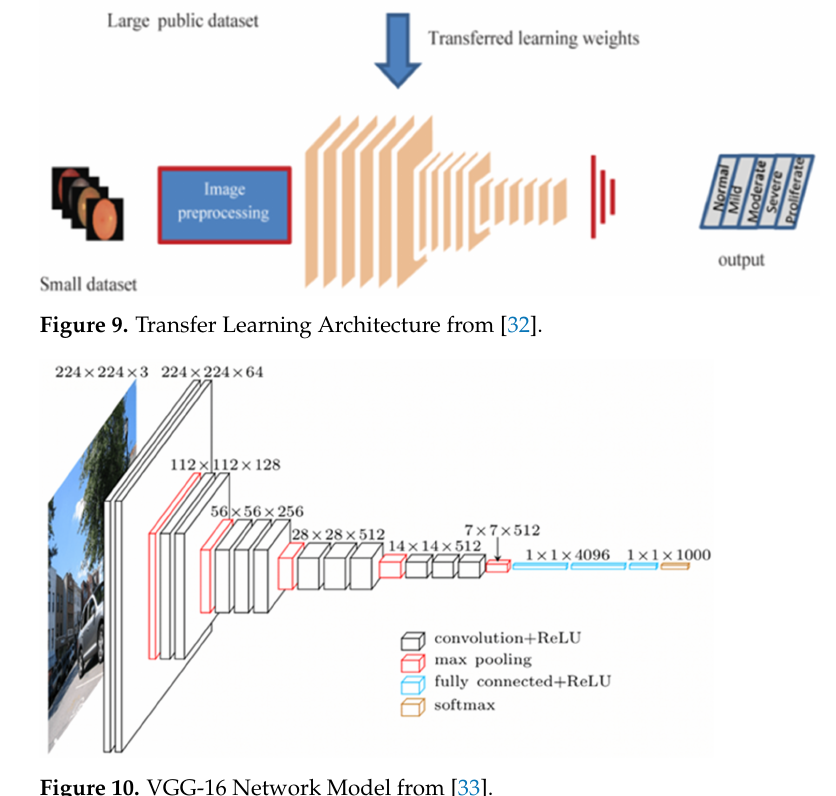
Figure 10. VGG-16 Network Model from